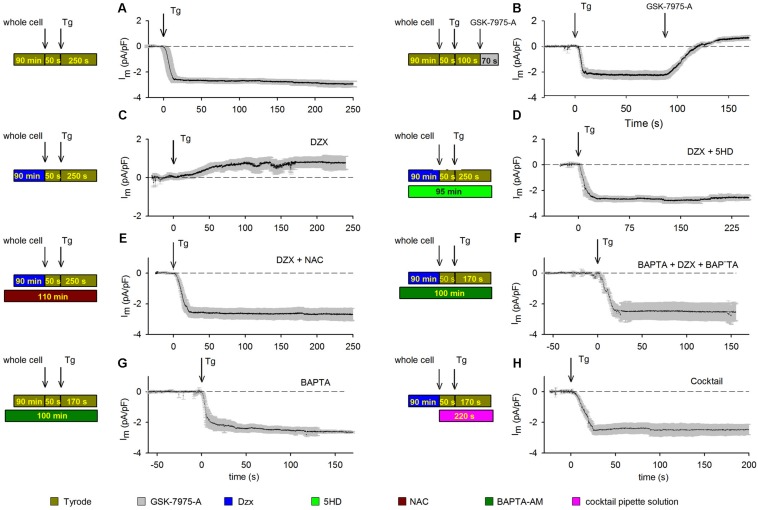
PPC inhibition of SOCs involves ROS and Ca2+-dependent inactivation. Visual summaries of experimental protocols are shown to the left of associated data graphs. Mean currents (±SEMs) are shown as a function of time and the HP was –80 mV in panels. (A) Membrane currents (n = 10) recorded from control cardiomyocytes treated with the SR Ca2+-ATPase blocker Tg (arrow). (B) The SOC inhibitor GSK-7975-A (arrow) blocked the inward current generated by Tg (n = 5); experiment otherwise as in panel (A). (C) Membrane currents recorded in Dzx-induced PPC in cardiomyocytes (n = 13). (D) Blockade of mitoKATP channels with pre/concurrent 5-HD treatment reinstated the inward-current response to Tg in PPC cardiomyocytes (n = 7). (E,F) Pre/concurrent treatment of PPC cardiomyocytes with the ROS scavenger NAC (n = 5) (E) or with BAPTA-AM (n = 5) (F) prevented the effect of Dzx on Tg-induced inward currents. (G) Pre/concurrent BAPTA-AM treatment of control cardiomyocytes (no PPC) did not alter currents alone (n = 6). (H) Supplementing the pipette solution with a cocktail that keeps mitochondria energized in cardiomyocytes pretreated with Dzx also prevented the effect of Dzx on Tg-induced inward currents (±SEM, n = 6).